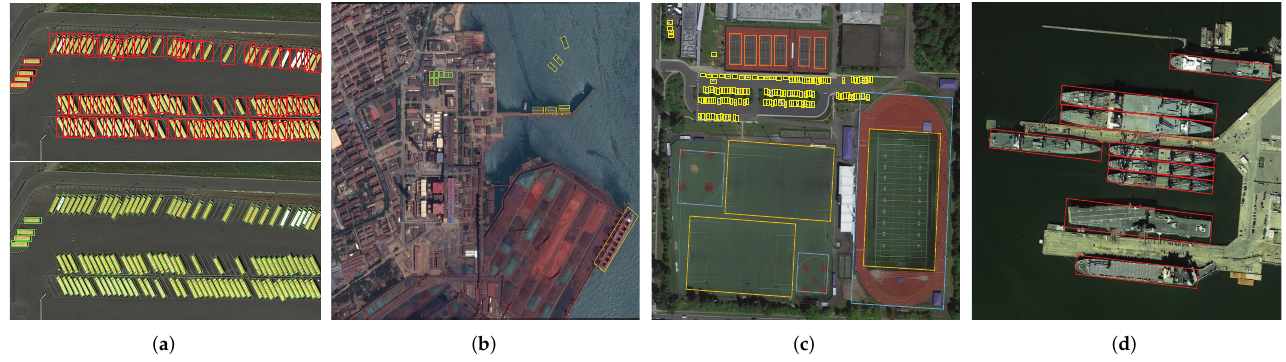
Figure 1. Some RSIs in the DOTA and HRSC2016 datasets. ( a ) The direction of objects in RSIs is always arbitrary. The HBB ( top ) and OBB ( bottom ) are two representation methods in RSI object detection. ( b ) Remote sensing images tend to contain complex backgrounds. ( c ) The scales of objects in the same remote sensing image may also vary dramatically, such as with small vehicles and track fields on the ground. ( d ) There are many objects with large aspect ratios in RSIs, such as slender